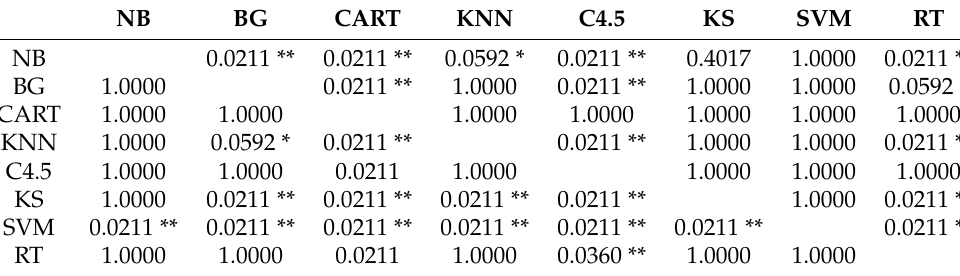
Table 10. Pairwise WSR test for kappa statistics of toddlers.